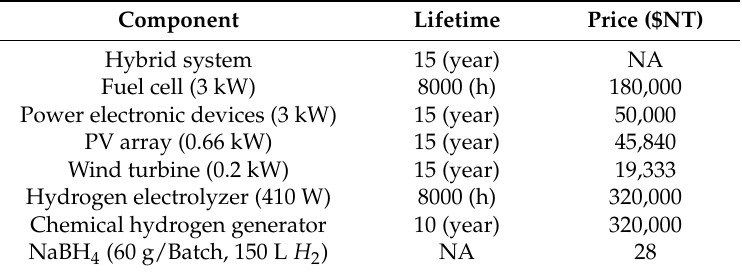
Table 2. Simulation